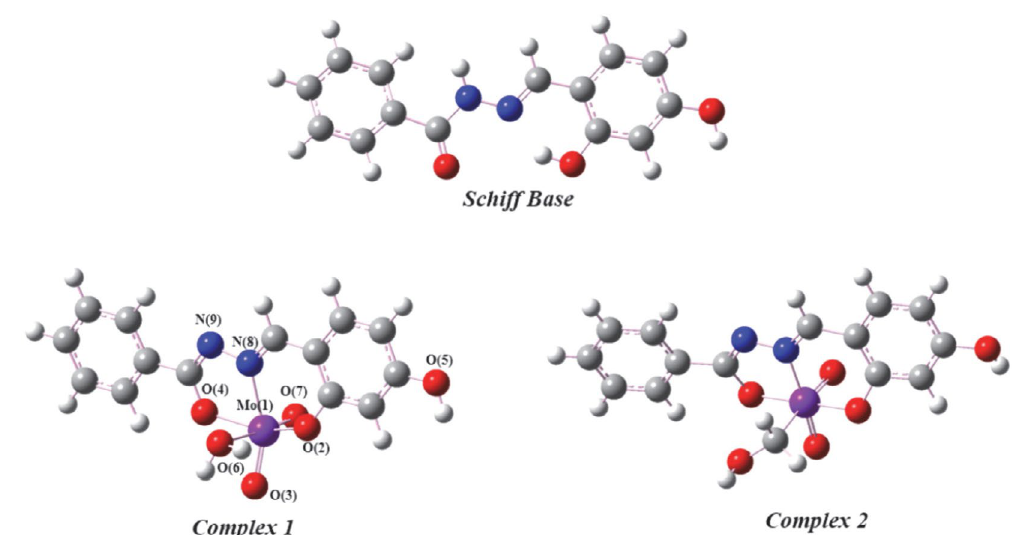
Figure 1. Optimized molecular structures of Schiff base and the two Mo complexes at CAM-B3LYP/LANL2DZ/6-311G* Table 1. Selected experimental and theoretical geometric parameters at CAM-B3LYP/LANL2DZ/6-311G* level of complex 1. Bond length (A°)